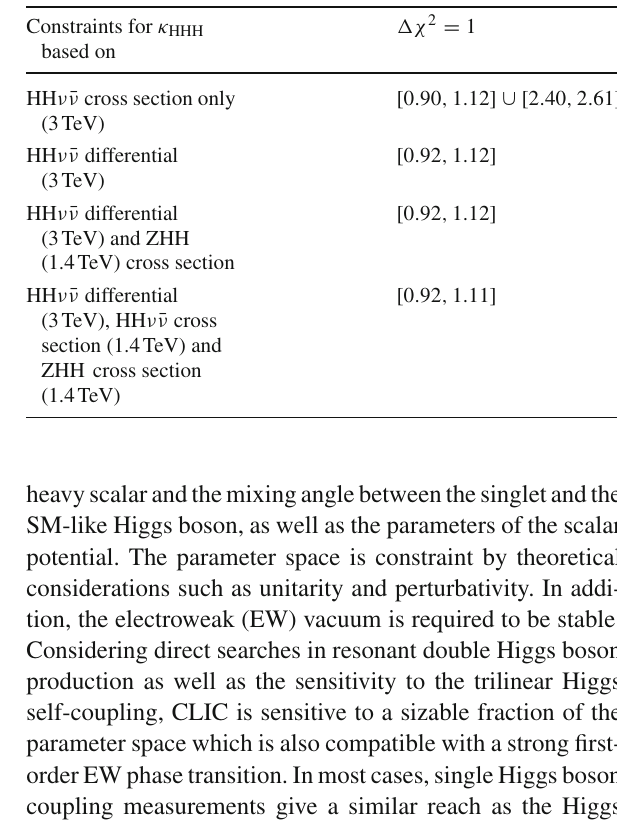
Fig. 9 (cid:9)χ 2 curves based on rate-only and differential information in the HH ν ¯ ν measurement at 3TeV without and with a combination with the measurement of the ZHH production cross section at 1.4TeV. As a comparison, the (cid:9)χ 2 for the case of the second energy stage only is shown